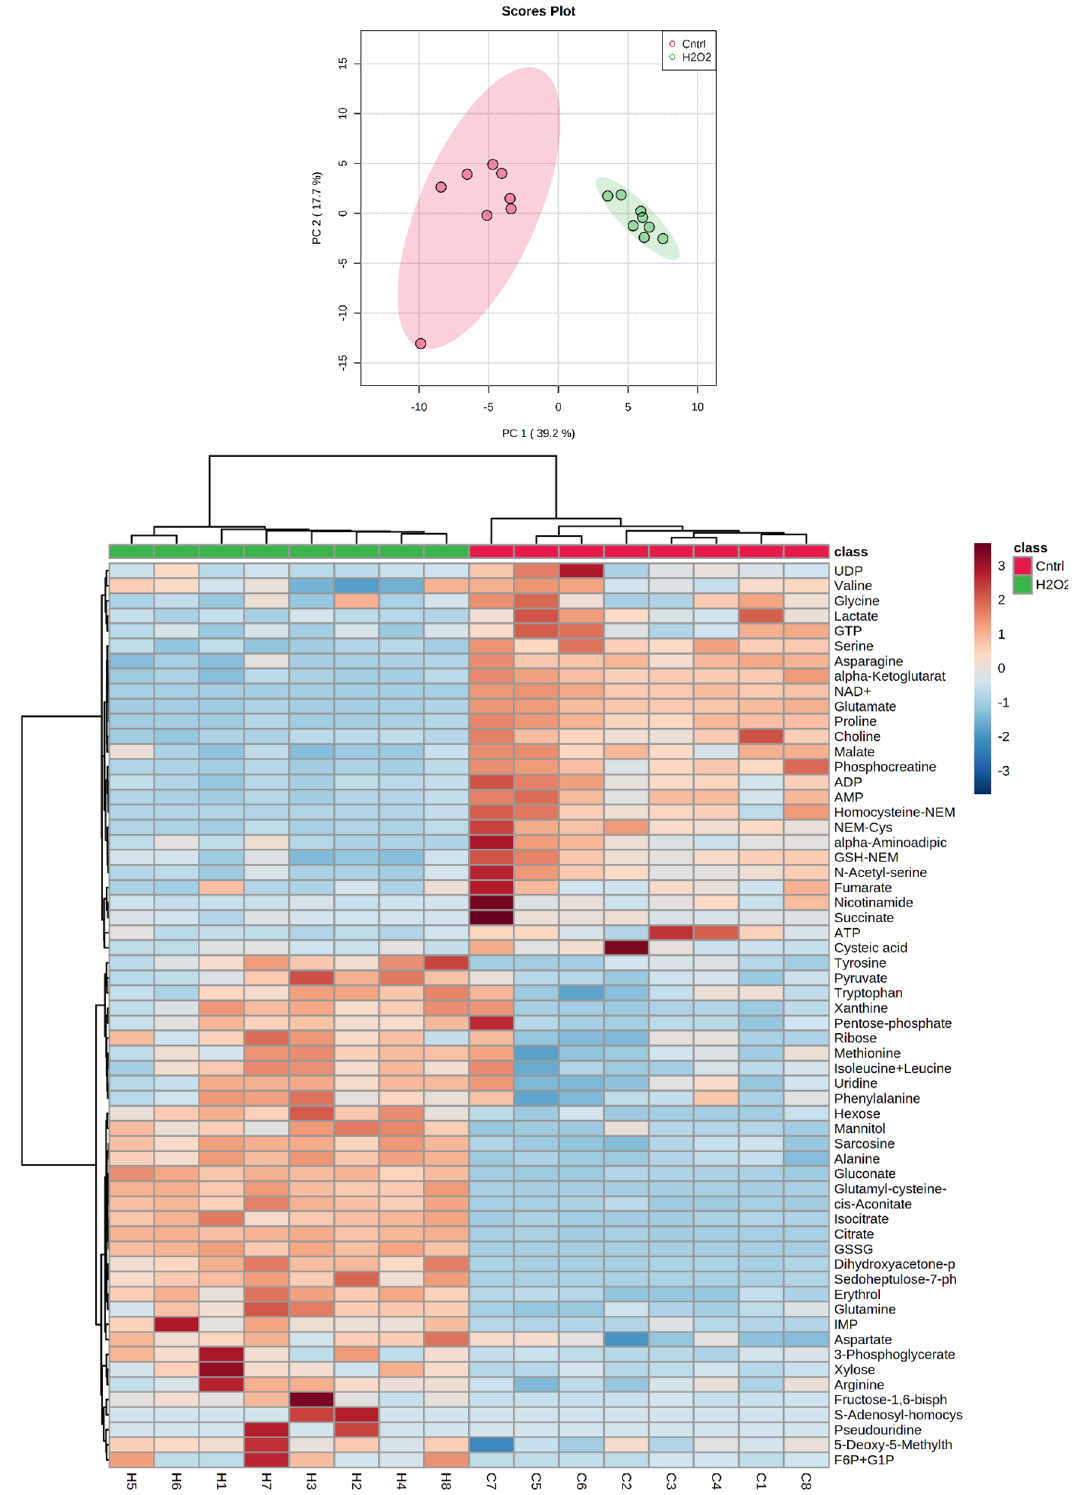
Figure 3. Principal component analysis and heatmap with hierarchical clustering of metabolomics data with 100 absolutely quantified compounds of 500 µM H 2 O 2 -treated samples and controls. The heatmap was constructed with top 60 features based on analysis of variance (ANOVA